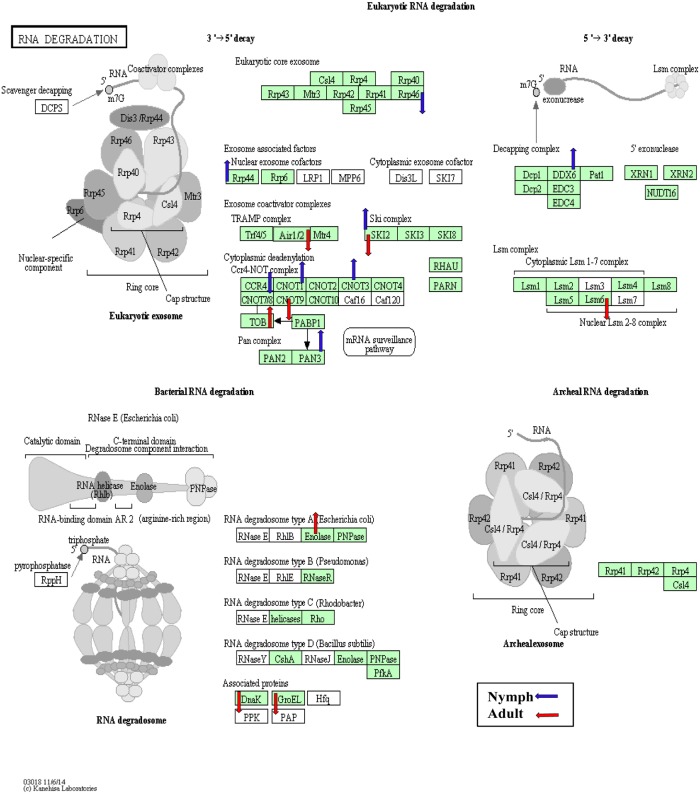
The RNA degradation KEGG pathway diagram showing the contigs that were differentially expressed (p<0.05) in nymphs (blue arrows) and adults (red arrows) in response to CLas infection.Of the assigned contigs (shaded in green), 17 were differentially expressed either in the nymphs or adults.